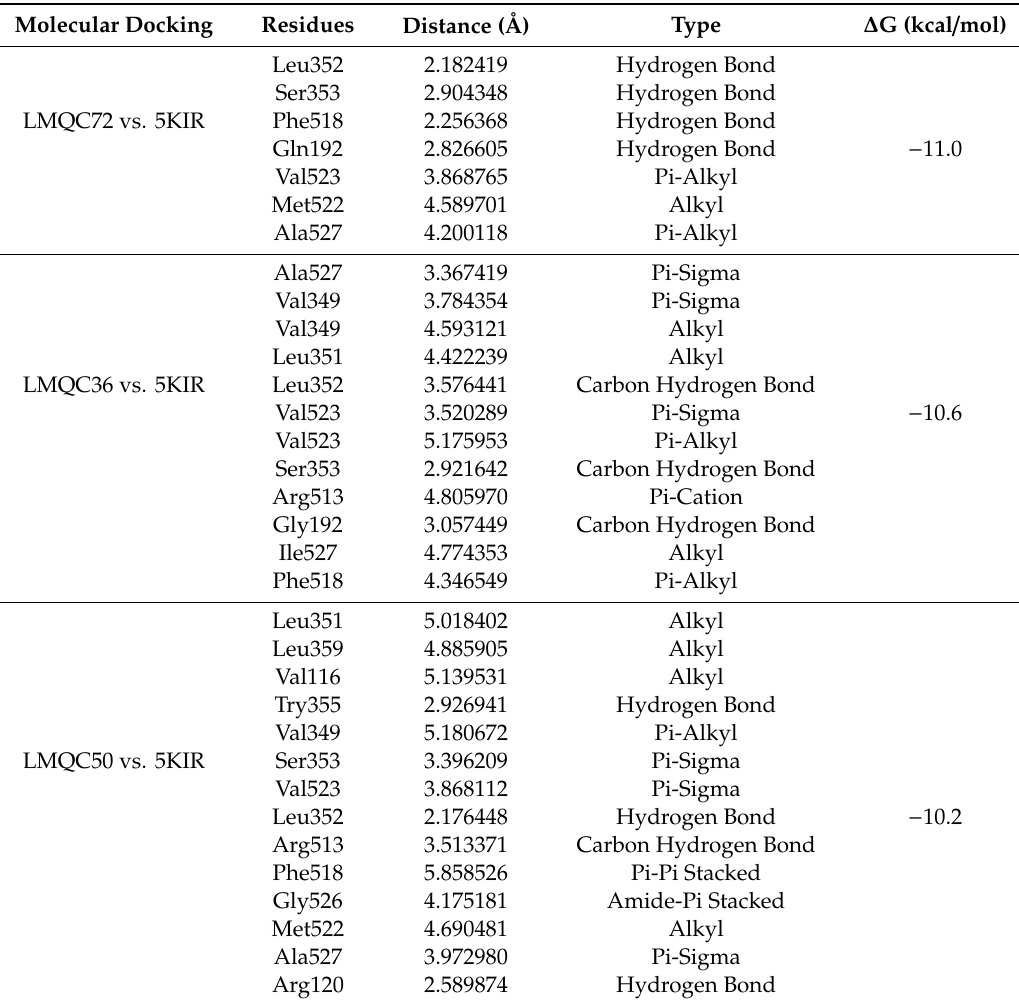
Table 4. Type of interactions and interacting residues of h COX-2 and compounds LMQC72, LMQC36, LMQC50. Molecular